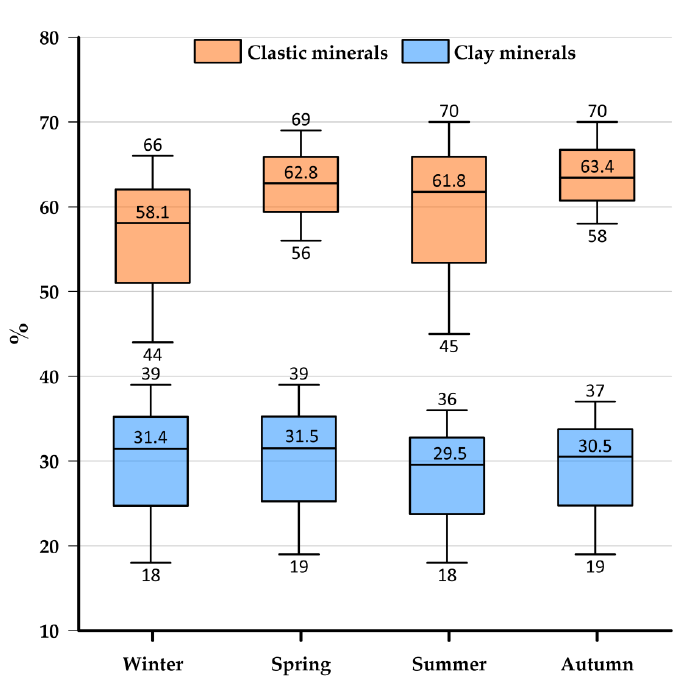
Figure 10. Average content and standard deviations of clastic and clay minerals in different seasons of a year.